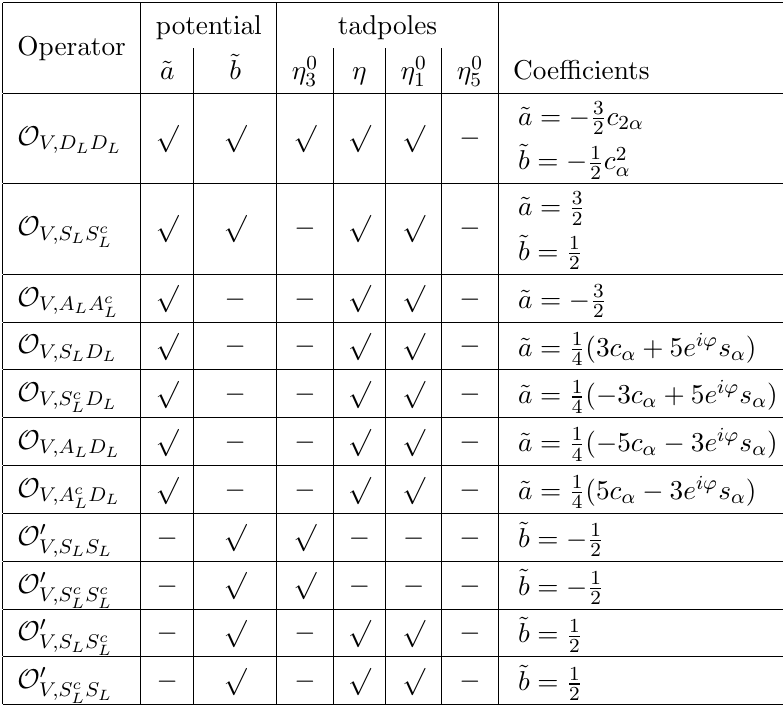
Table 2 . Contribution of the operators containing left-handed spurions to the pNGB potential, and presence of tadpoles for the neutral pNGBs except the